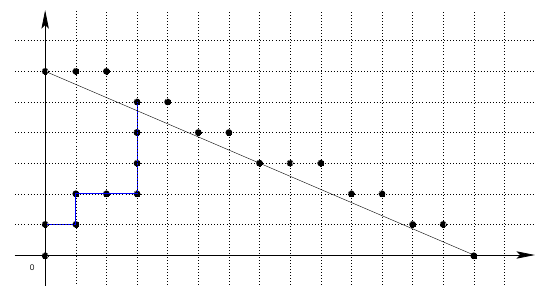
Fig. 1: An example of walk in W +